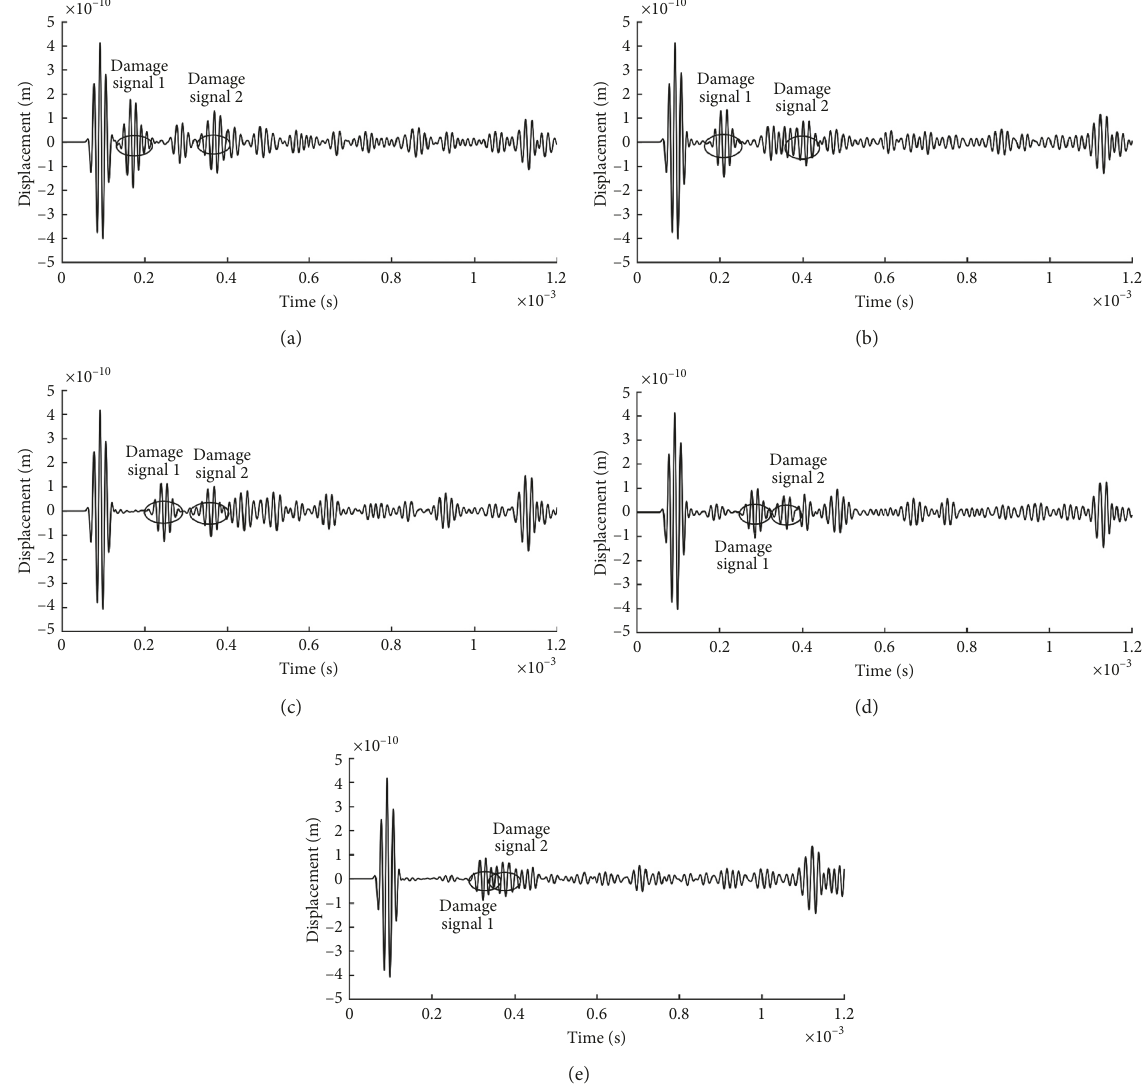
Figure 9: Time domain diagram of guided signals with different relative distances. (a) Relative distance is 0.5m. (b) Relative distance is 0.4m. (c) Relative distance is 0.3m. (d) Relative distance is 0.2m. (e) Relative distance is 0.1 m.